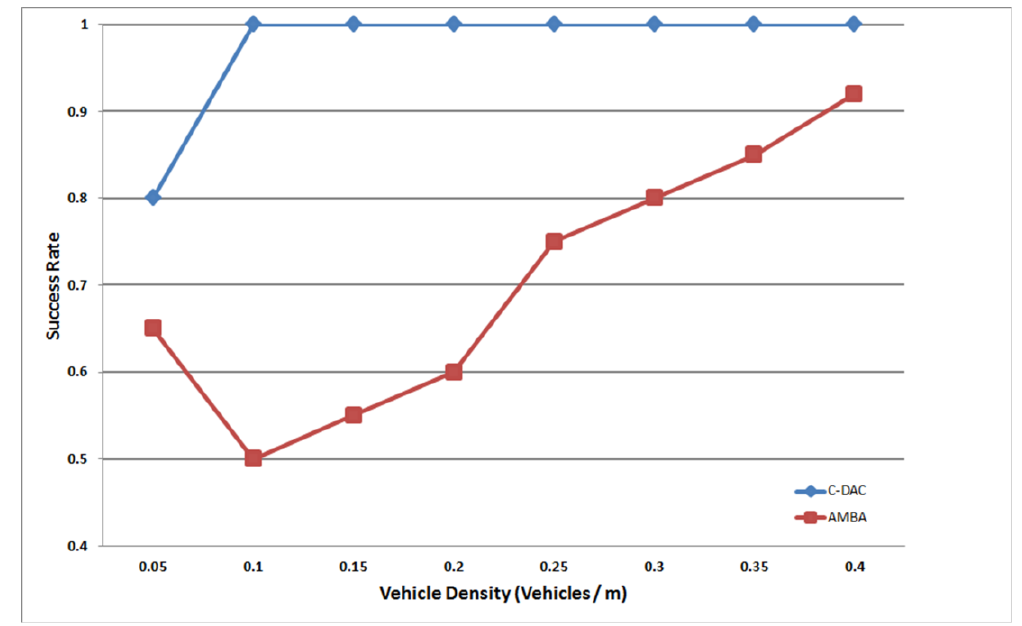
Figure 7. Percentage of vehicles within 3 km that received the emergency information successfully